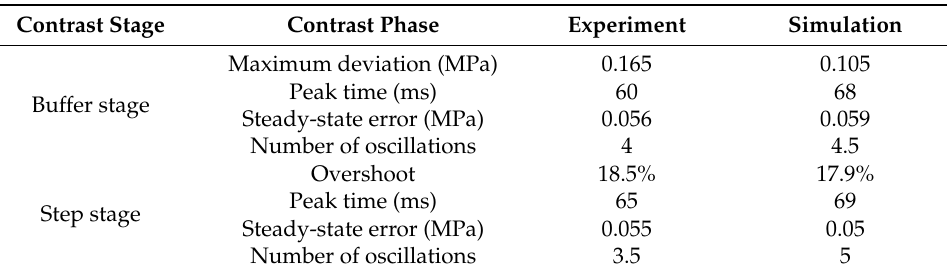
Table 3. Test and simulation comparison for 2D digital buffer valve.